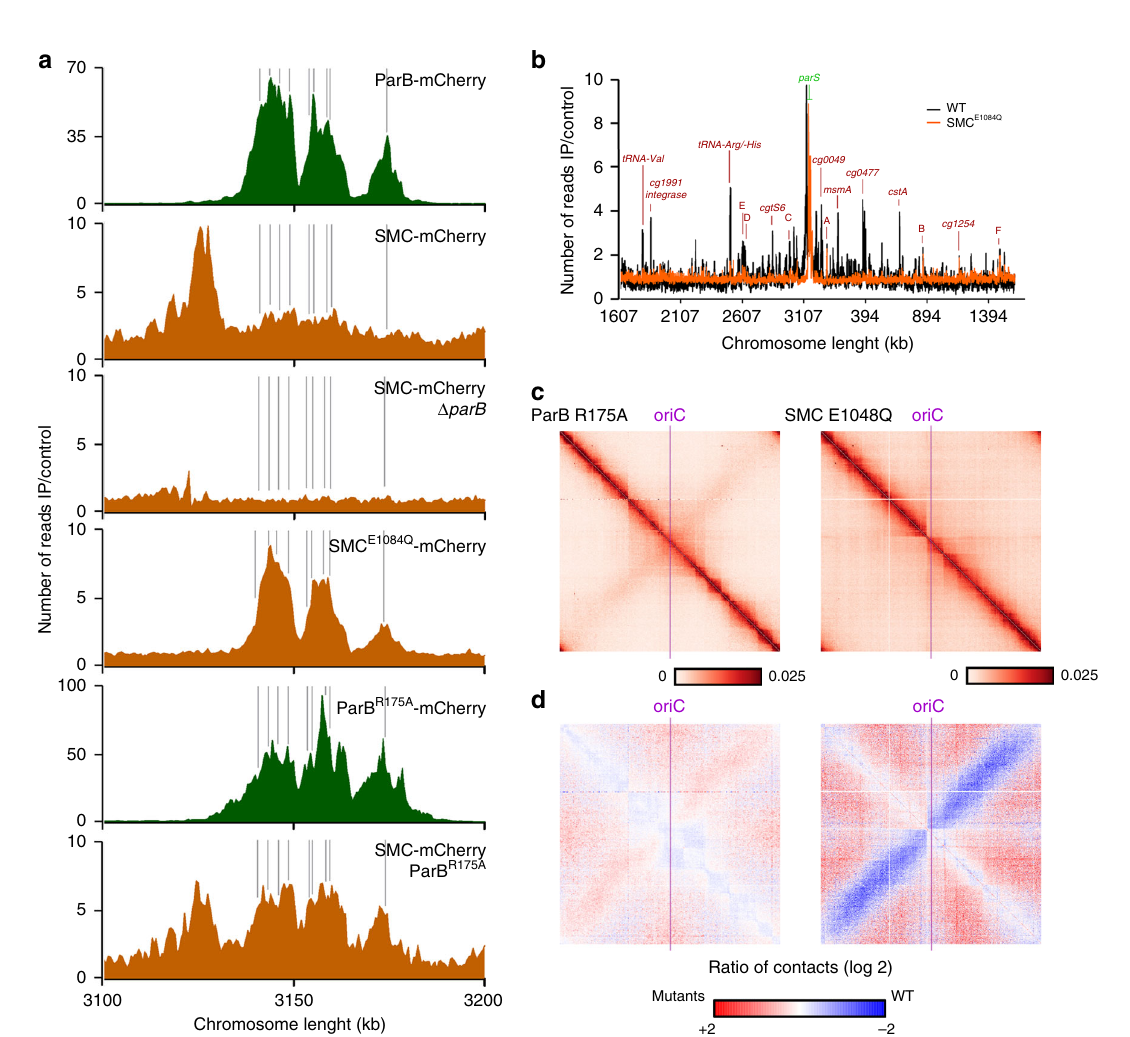
Fig. 4 Chromosomal SMC loading is mediated by ParB at parS sites. a SMC enrichment at parS sites (gray) is ParB-dependent. ChIP-seq of ParB-mCherry (green; CBK006 and CBK047) and SMC-mCherry (orange; CBK012, CBK014, CBK051, and CBK049) in strain backgrounds as indicated. Depicted are chromosomal ranges of 3.1 – 3.2 Mb, bin size 0.5 Kb. b Whole-genome ChIP-seq data of strains harboring SMC-mCherry wild type (gray, CBK012) or E1084Q mutant (orange, CBK050). SMC enrichment at parS sites and at other loci (red letters), in particular tRNA gene clusters and at rRNA genes ( a – f ) is illustrated in 0.5 Kb bins in linear scale along the chromosome with an x -axis centered at oriC . c Normalized contact map of mutant strains parB ∷ parB R175A (CBK047) and d the corresponding differential map indicating the log of the ratio (wild-type norm/mutant norm) as in Fig.